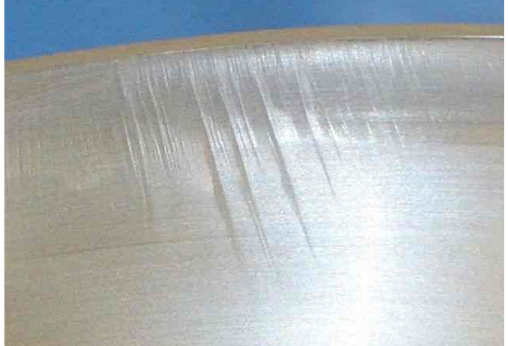
FIG. 18. Slip lines of the crystal on a half-cell after deep